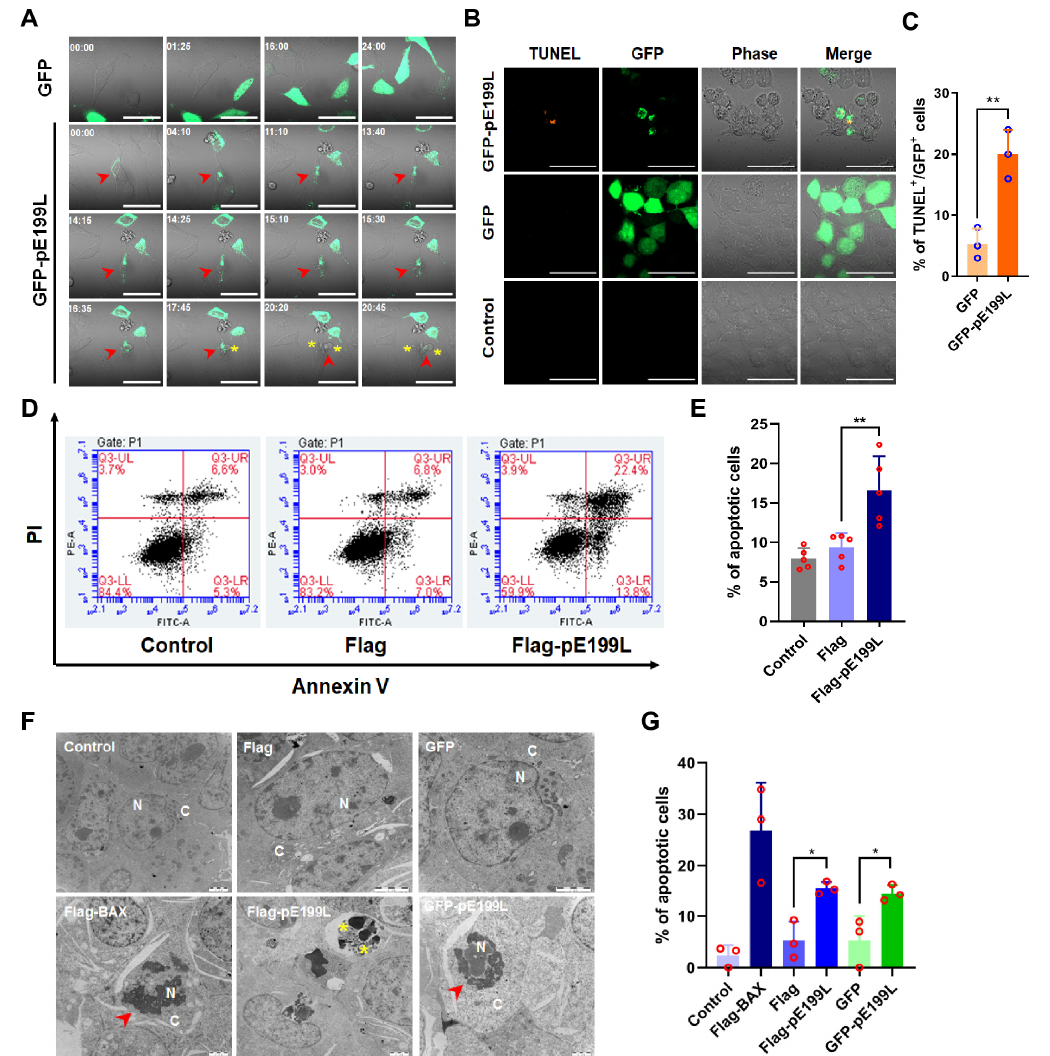
Figure 3. ASFV pE199L induces apoptosis in vitro. ( A ) Representative morphology images of GFP-pE199L-expressing HeLa cells. HeLa cells were transfected with pGFP or pGFP-E199L for 12 h and the morphological changes in 15 random fields were monitored under a 63 × oil objective using real-time confocal microscopy for 24 h. Time stands for relative time (hh:mm). Scale bar: 50 µ m. Yellow asterisk: formation of vesicles; red arrowhead: apoptotic cells. ( B ) HEK293T cells were transfected with pGFP or pGFP-pE199L plasmids for 36 h and then treated with TUNEL assay as described in Materials and Methods. A representative confocal image illustrated TUNEL-labeled cells (orange) in GFP-pE199L-expressing HEK293T (GFP, green) but not GFP-expressing HEK293T cells. Scale bar: 50 µ m. ( C ) Statistical analysis of the percentage of the TUNEL-labeled cells. At least 100 GFP or GFP-pE199L expressing cells in Figure B were counted under a 63 × oil objective and the results are shown as mean ± SD values from 3 independent experiments. ( D , E ) Analysis of the pE199L-induced apoptosis. HEK293T cells were transfected with pFlag-E199L or pFlag for 36 h, and then stained with Annexin V-FITC and PI. In total, 10,000 cells were analyzed by flow cytometry ( D ). The percentage of apoptotic cells is shown as the mean ± SD values from 5 repetitions in parallel ( E ). ( F , G ) Observation of apoptotic cells by transmission electron microscopy (TEM). HEK293T cells were transfected with pGFP-E199L, pGFP, pFlag-E199L, or pFlag for 36 h. The pFlag-BAX was transfected for 36 h as a positive control. The morphology of apoptotic cell was observed by TEM ( F ). N: nucleus; C: cytoplasm; red arrowhead: hyperchromatic nuclear and karyopyknosis; yellow asterisk: apoptotic bodies. Scale bar: 2 µ m. Statistical analysis of the percentage of the apoptotic cells ( G ). At least 180 cells from 3 or 4 cell sections were randomly counted and the results are shown as mean ± SD values from 3 independent experiments. The significance of the differences between the groups was determined by the Student’s unpaired t -test with 2-tails (parametric test) or the ordinary ANOVA test with Dunnett (* p < 0.05, ** p <